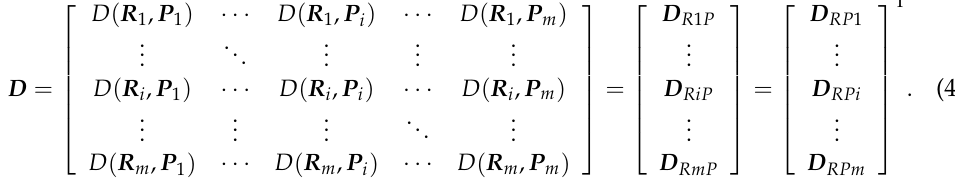
Figure 4. Schematic of the MTHardNets with K nearest negative samples using the EWLF, where ( K + 2) image patches are parallelly fed into the same HardNet, then the matching descriptors ( R i , P i ) and non-matching descriptors ((cid:2170) (cid:3036)(cid:2869)(cid:2929)(cid:2930) , ⋯ , (cid:2170) (cid:3036)(cid:3012)(cid:2930)(cid:2918) ) are respectively outputted. The L u and w u represent the loss and weight, respectively, and the EWLF can be expressed by L given in Equations (6) and (7).